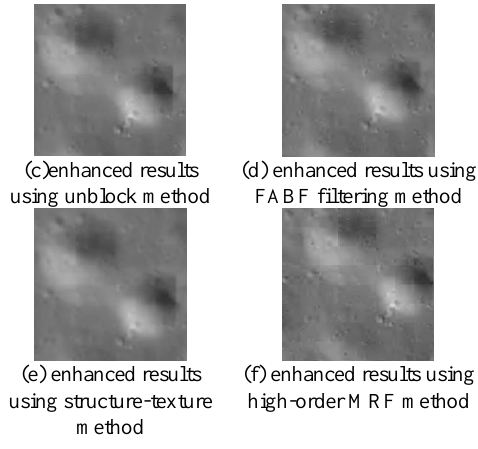
Figure 2. Visual quality comparison of simulated 1:64